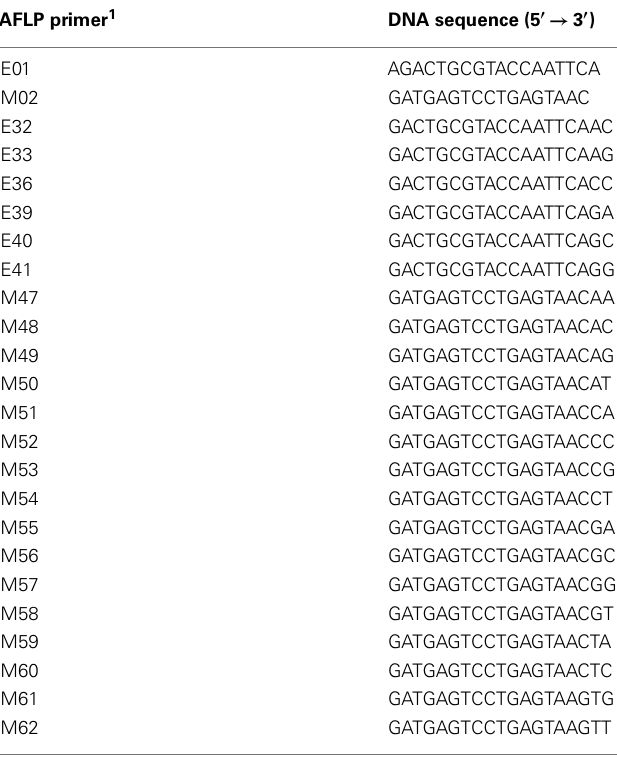
Table 1 |AFLP primers used for bulked segregant analysis (BSA), genetic linkage mapping, and cluster analysis in N. langsdorffii